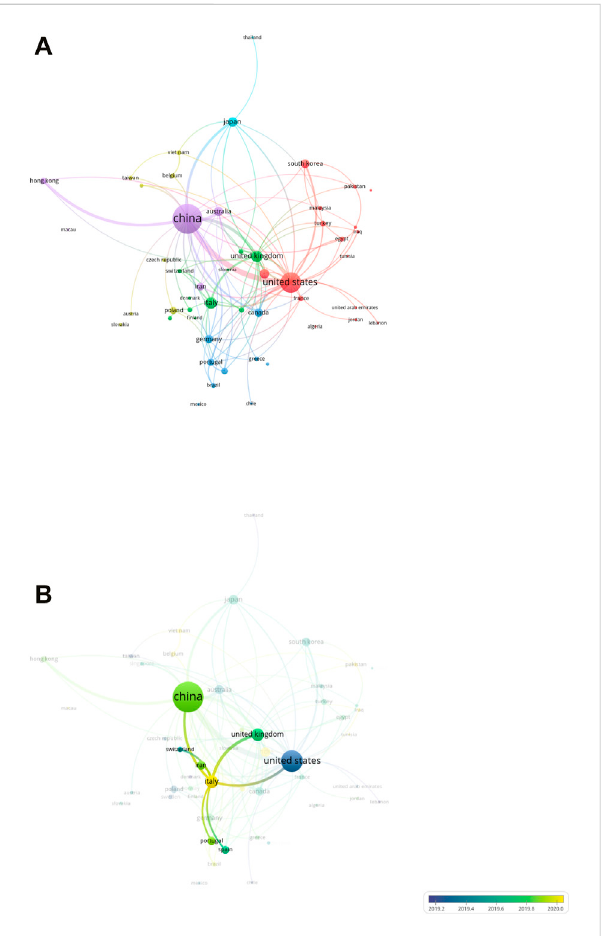
FIGURE 8 Co-authorship relationships in terms of countries: (A) Countries clusters and (B) country with the most recent average publication, Italy.